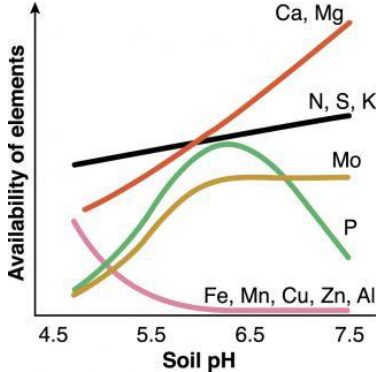
Figure 1. Nutrient availability in relation to soil pH